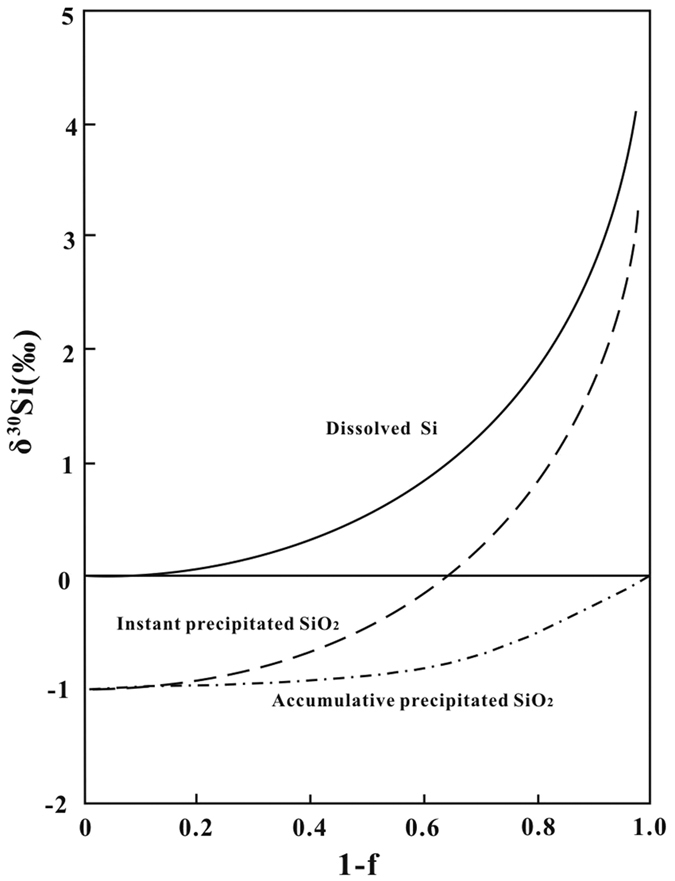
Plot showing silicon isotope fractionation during SiO2 precipitation from ocean water in a Rayleigh process, where f is the fraction of remaining dissolved Si in ocean water and 1-f is the fraction of accumulated precipitated SiO2.The δ30Si of the starting ocean water is assumed to be 0‰ and the Si isotope fractionation factor between SiO2 precipitate and ocean water (αPre-SW) is 0.999.